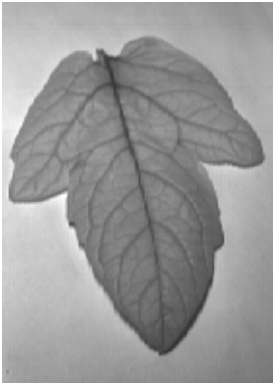
Figure 2. Hyperspectral image at a 1390 nm wavelength.